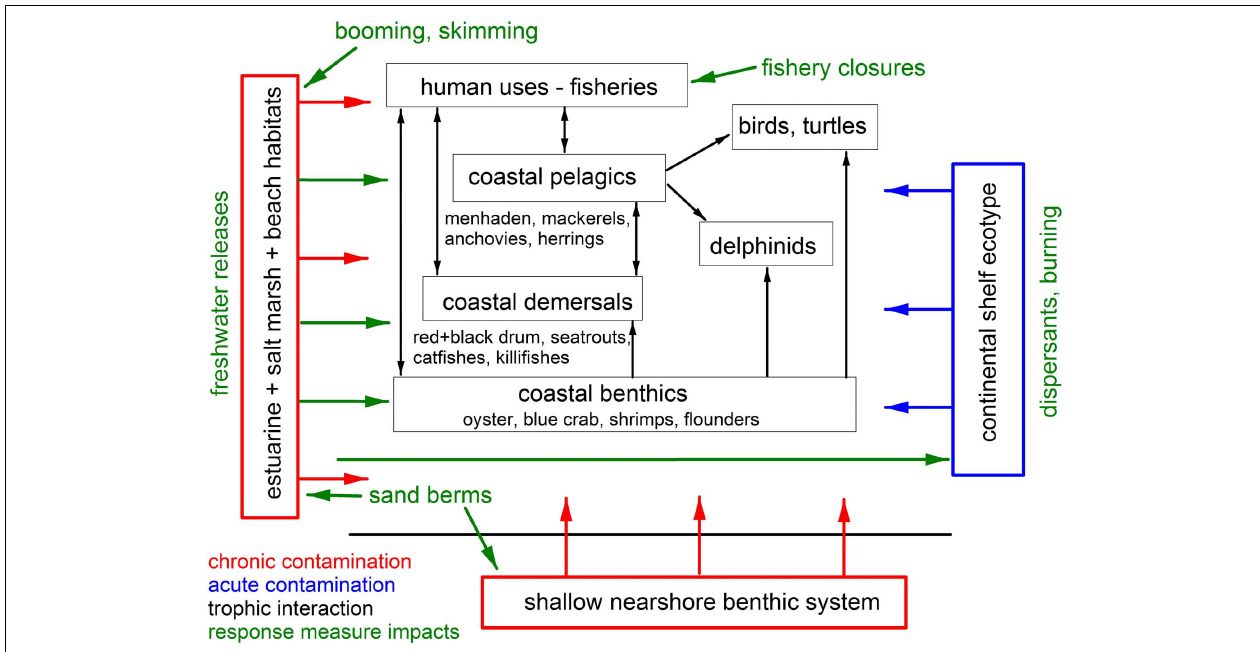
FIGURE 2 | Schematic of the source (in blue), pollutant reservoirs (in red) and impacted species groups, and their interrelationships (black arrows) for the Deepwater Horizon oil spill affecting coastal and nearshore resources in the northern GoM. Green arrows indicate the directionality of potential impacts of oil spill response measures on resource